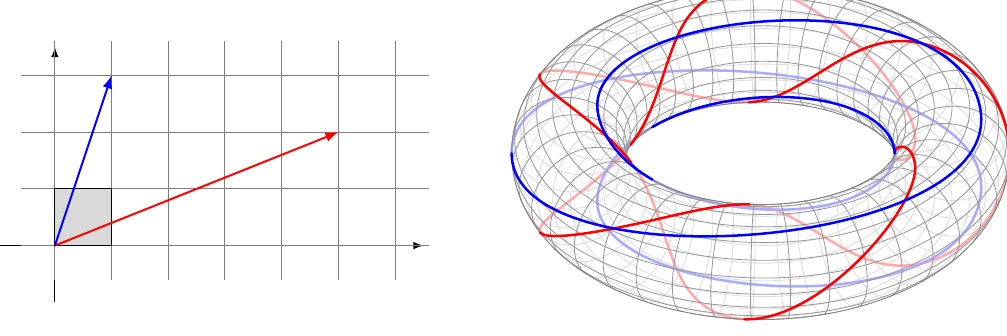
Figure 3 . Closed geodesics on the torus labeled by the integers (1 , 3) (blue) and (5 , 2) (red) as segments in R 2 and on a three-dimensional